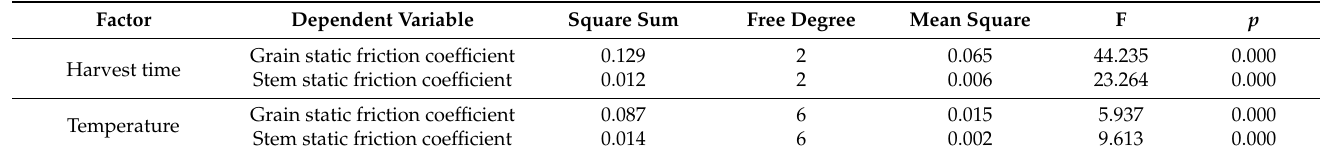
Table 7. ANOVA results of the effects of harvest time and temperature on the average static friction coefficients of rice grains and stems.